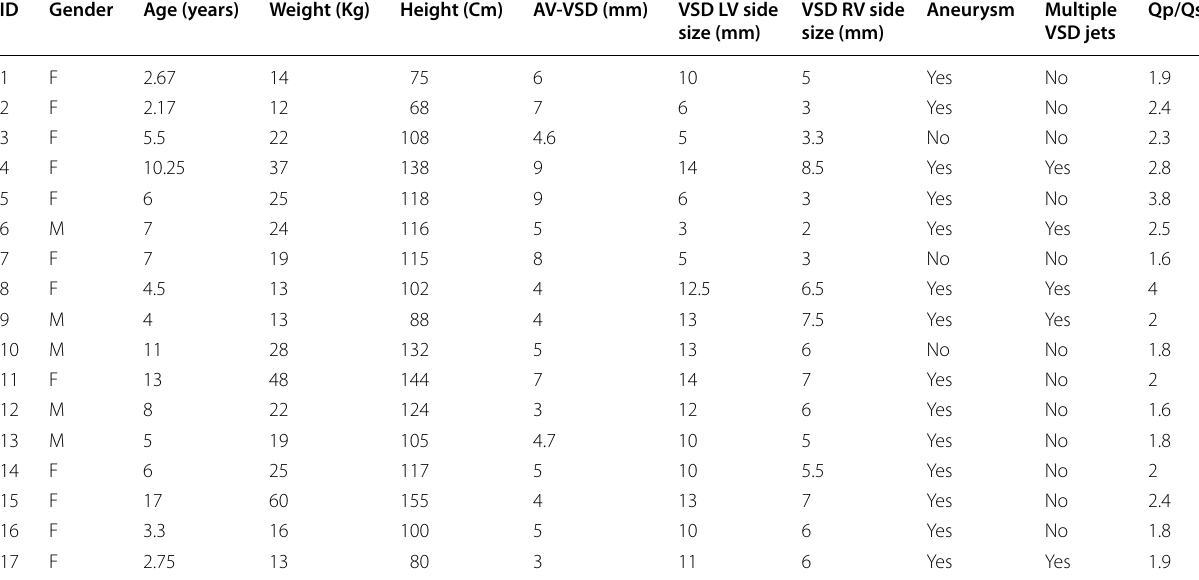
Table 2 VSDs characteristics